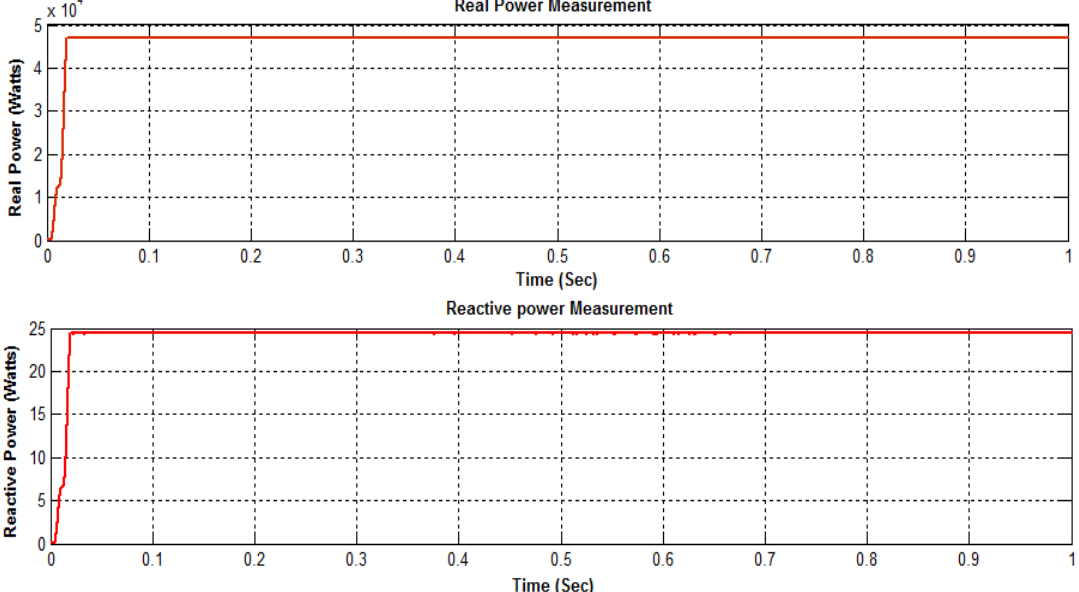
Figure 11. Voltage and current on the load side. The implementation of SVPWM defined the voltage vector and the reference voltage vector as traveling between the axis. The sector determination of the vector voltages is shown in Figure 12. The sectors of the reference voltages are likely to follow the determined sectors shown below.